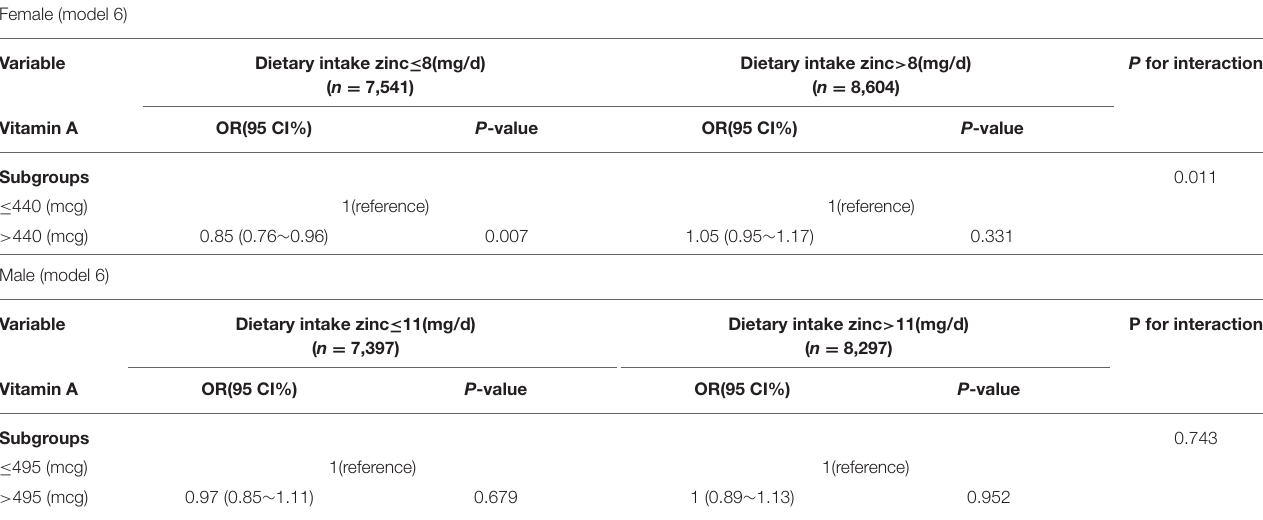
TABLE 2 | Effect of low and high zinc intake groups on the association between vitamin A and depression in dichotomous and trichotomous models. Female (model